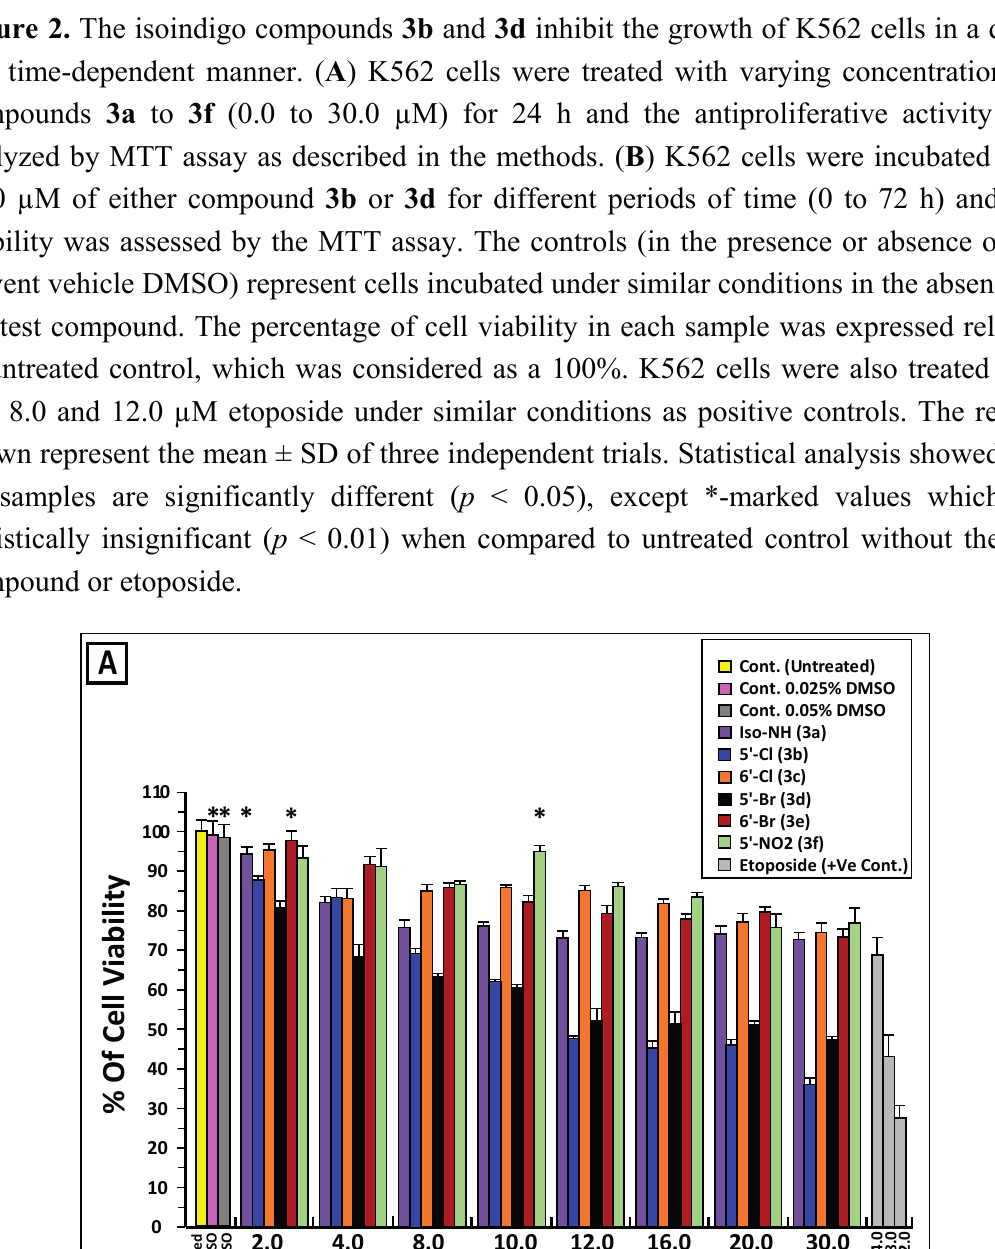
Figure 2. The isoindigo compounds 3b and 3d inhibit the growth of K562 cells in a dose- and time-dependent manner. ( A ) K562 cells were treated with varying concentrations of compounds 3a to 3f (0.0 to 30.0 µM) for 24 h and the antiproliferative activity